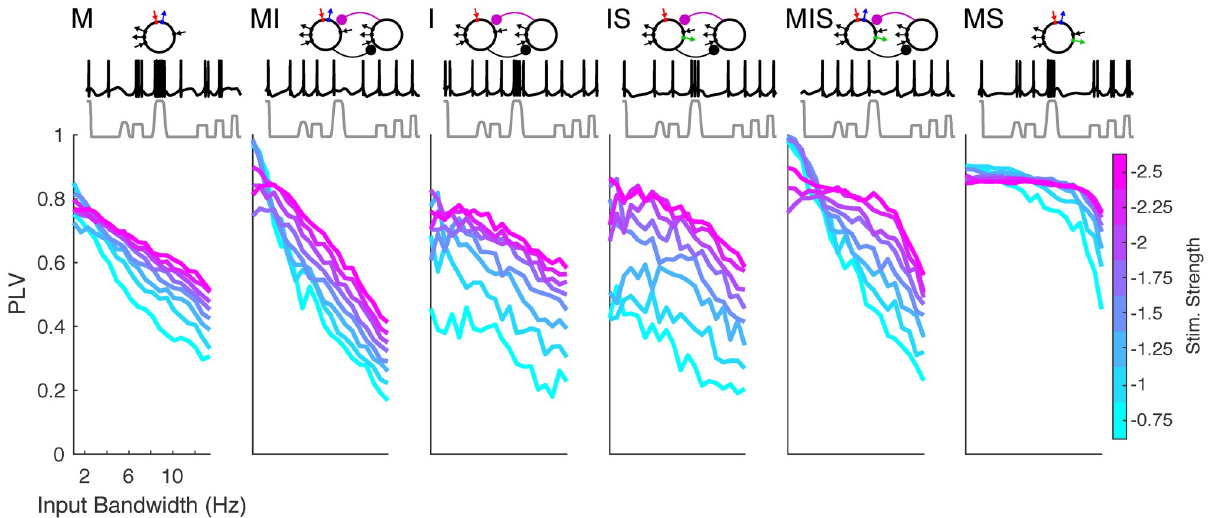
Fig 4. Phase-locking to quasi-rhythmic inputs. Plots show the (spike-rate adjusted) phase-locking value of spiking to input waveform, for inputs of varying input strength as well as varying bandwidth and regularity (see Section 4.3.2). All inputs have a center frequency of 7 Hz. Schematics of each model appear above. Sample traces from each model are shown in black, in response to inputs shown in gray, having a bandwidth of 10.65 Hz and an input gain of 1.1; 1.1 second total is shown.